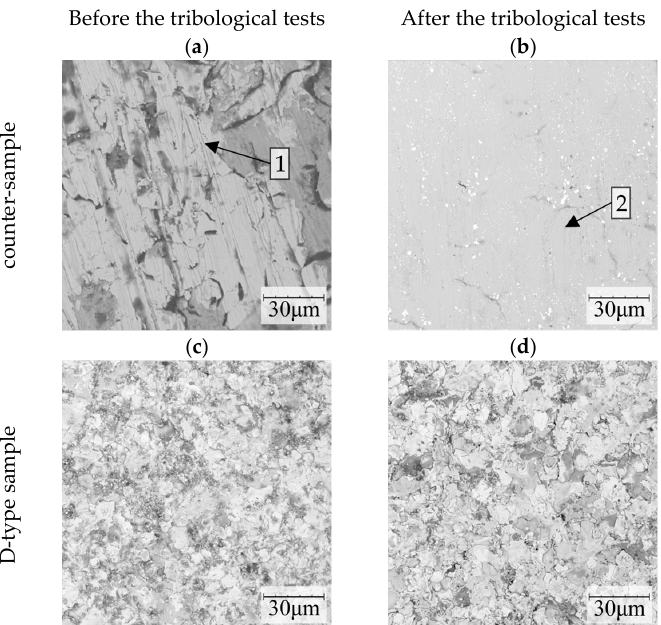
Figure 11. The surface morphology of the counter-sample ( a , b ) that co-operated with the D-type sample ( c , d ) with the deposited carbide coating with the addition of 10 wt%. YSZ, before and after the tribological tests. 1—scratches being an effect of the treatment process, 2—scratches being an effect of the wear process.